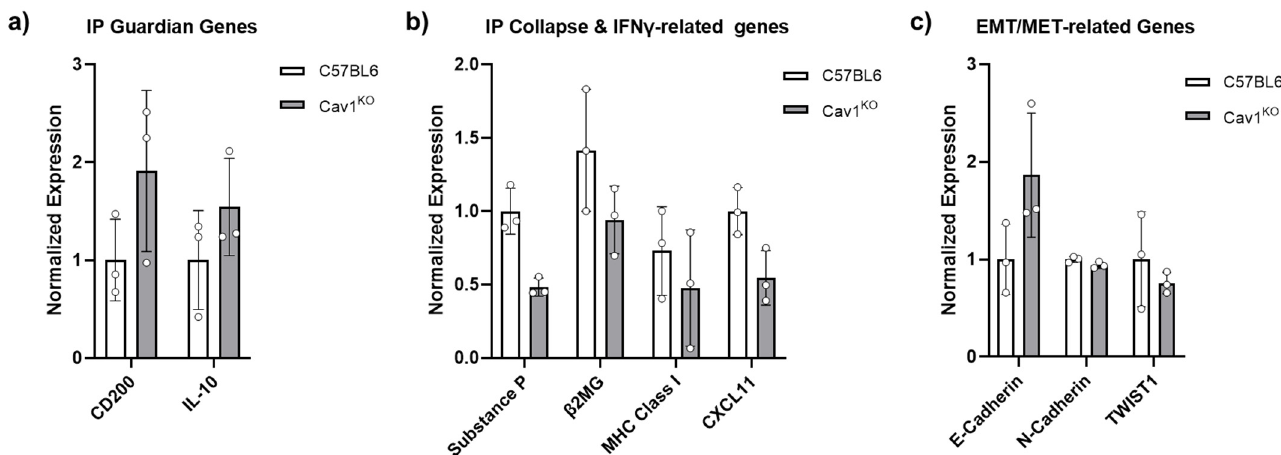
Figure 4. Differential regulation of IP Guardian/Collapse and EMT/MET-related genes in Cav1 knockout mouse skin. ( a ) Full thickness skin biopsy punches from location matched 8-week-old female C57BL6 (i.e., Cav1 WT type) and global Cav1 knockout (Cav1 KO ) mice were utilized to assess expression levels of IP Guardian (CD200, IL-10), IP Collapse (Substance P, β 2MG, MHC Class I, CXCL11), and EMT/MET-related genes (E-cadherin, N-cadherin, TWIST1) by qRT-PCR. Cav1 KO mouse skin exhibits upregulation of IP guardian genes and a marker of epithelial cells (E-cadherin), as well as a downregulation of IP collapse and EMT related genes. Error bars correspond to standard deviation from n = 3 mice.